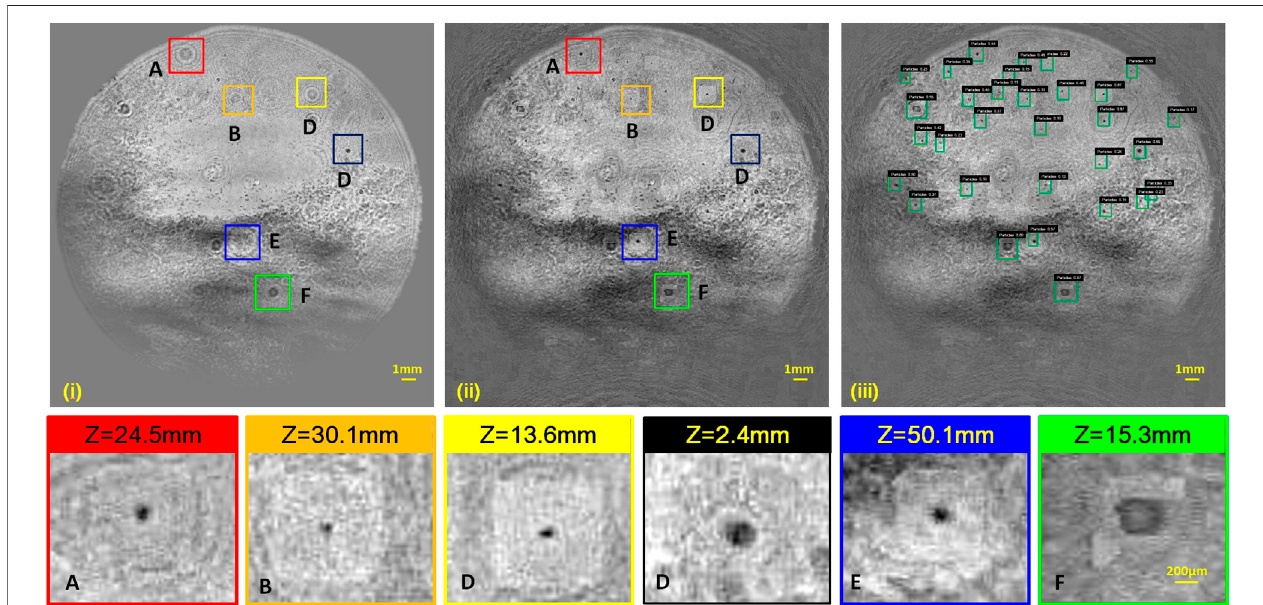
FIGURE 3 | Raw, refocused holograms and target recognition of plume particles (i) Raw hologram. (ii) Refocused hologram of particles at z 0 = 0. (iii) target recognition. (A – F) Refocused holograms for particles with diameters of 169, 65,103, 250,159, and 533 μ m,